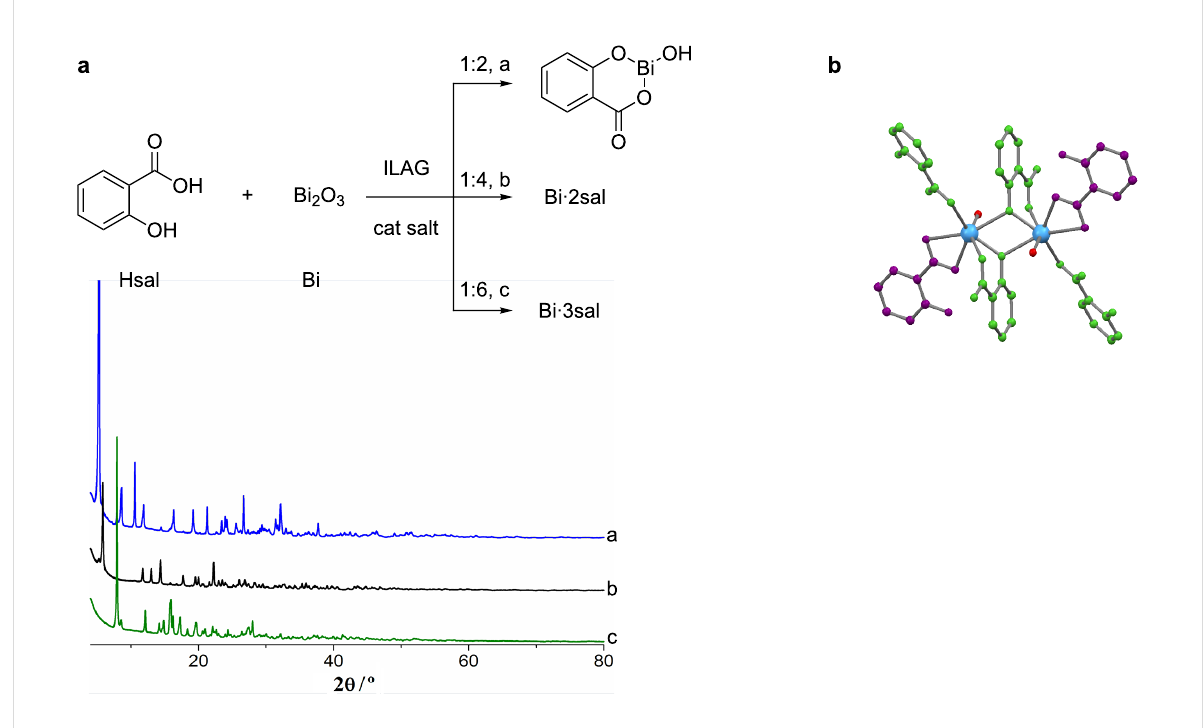
Figure 7: a) Mechanochemical reaction of salicylic acid with Bi 2 O 3 yielding bismuth mono-, di- and trisalicylate, depending on the starting conditions; b) crystal structure of a bismuth disalicylate determined by XRPD data. Reprinted with permission from [149], copyright 2015